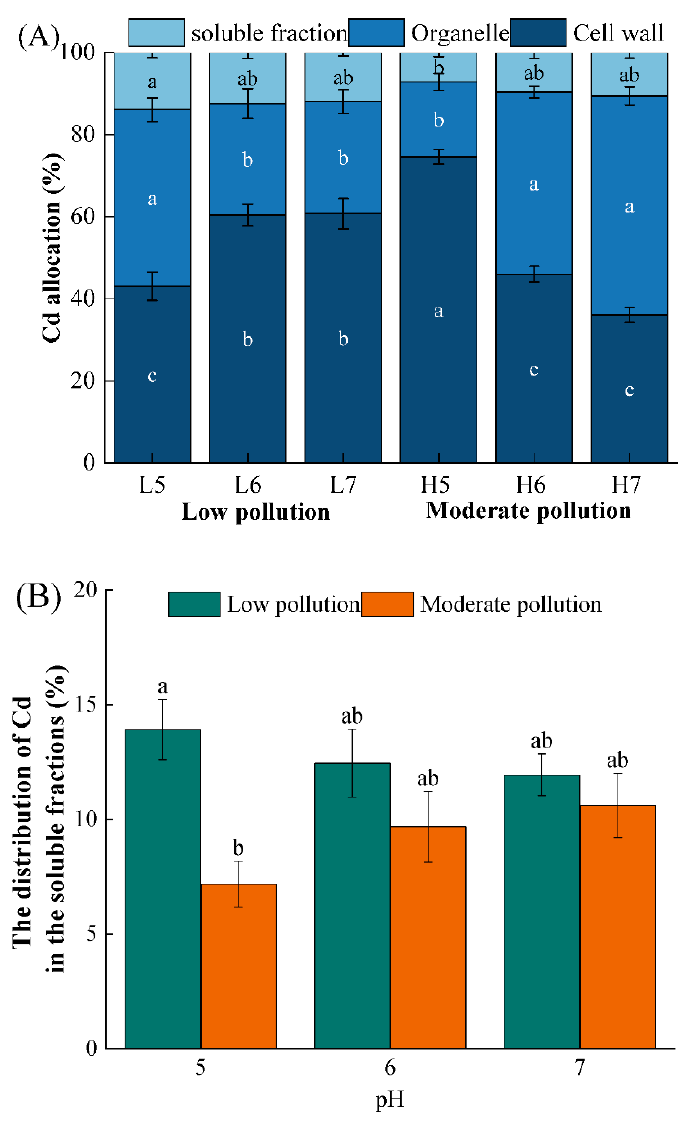
Figure 3. Subcellular cadmium (Cd) distribution ( A ) and the distribution of Cd in the soluble fractions ( B ) under three soil pH values at two Cd levels. Different lowercase letters indicate significant differences between different pH treatments.